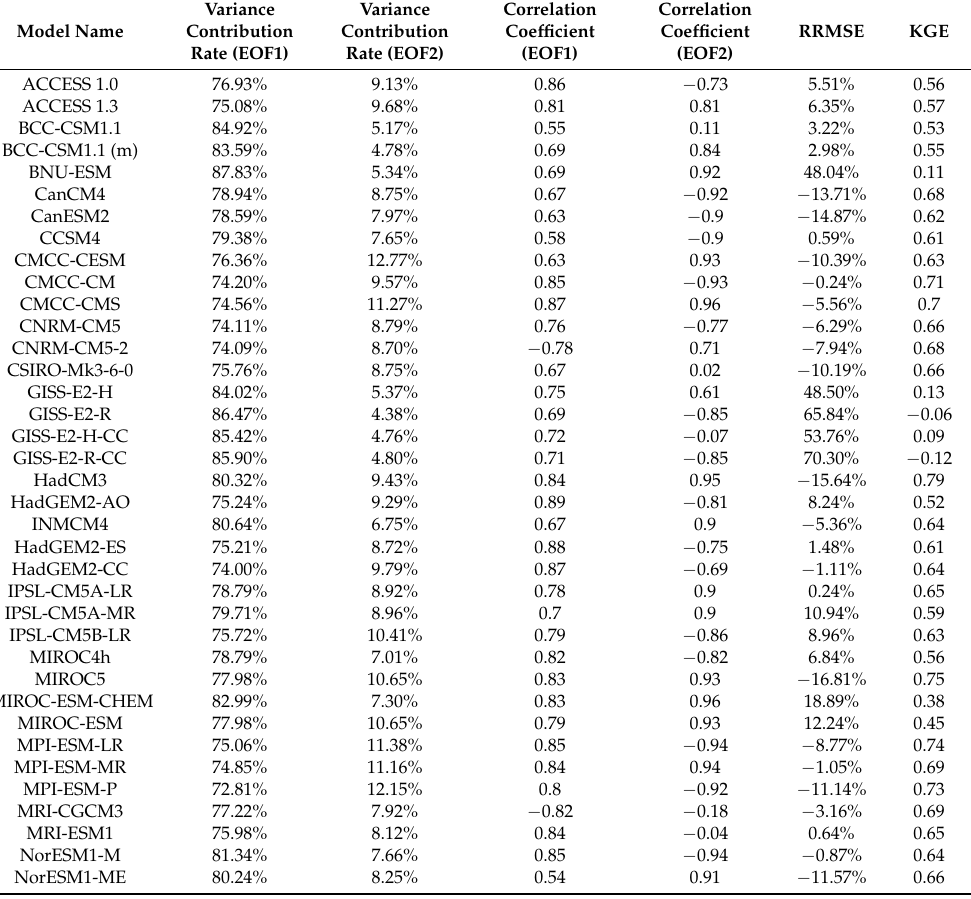
Table 2. Statistical summary of the comparisons between the 37 GCM simulations and observations over Central Asia for the period 1986–2005. KGE: Kling–Gupta efficiency.